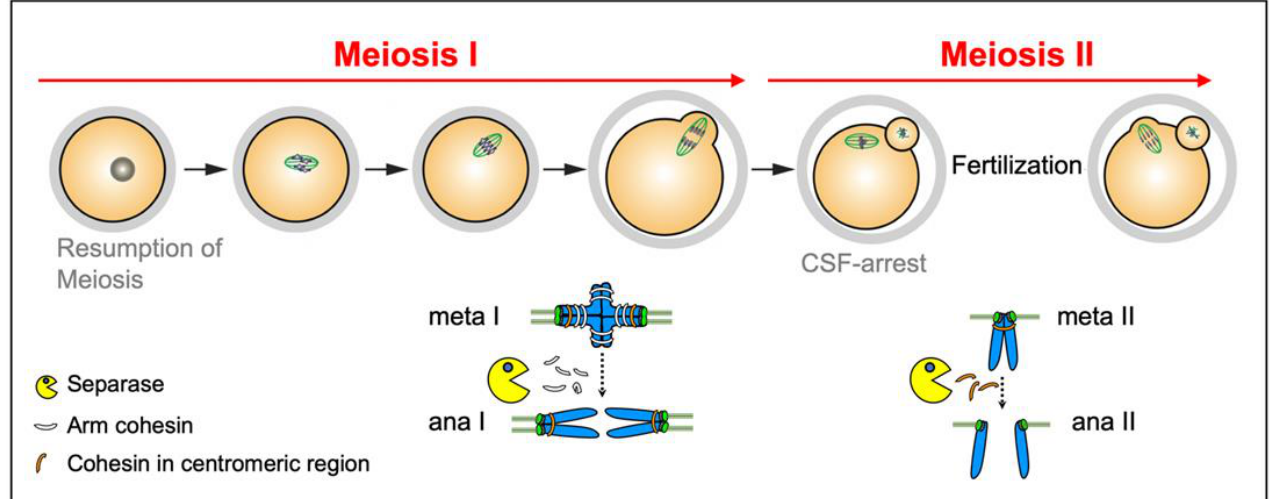
Figure 1. Mouse oocyte meiosis. Prophase I arrested oocytes are found in the ovaries of adult mice. Upon hormonal stimulation, they resume meiosis, with nuclear envelope breakdown and progression through meiosis I, followed by meiosis II. Oocytes arrest in the metaphase of meiosis II (CSF-arrest) to await fertilization, which induces anaphase II and exit from meiosis II. The meiotic divisions in oocytes are highly asymmetric to generate a small polar body that degenerates to maintain the volume of the oocyte for future embryo development. The segregation patterns are fundamentally different in meiosis I and II and are indicated in the scheme below, placed beyond the corresponding oocyte cell cycle stages. Separase (in yellow) removes arm cohesin (white) in meiosis I and centromeric cohesin (orange) in meiosis II. The typical cross-shaped form of paired chromosomes in meiosis I is due to chiasmata holding chromosomes of different parental origins together and the fact that mouse chromosomes are telocentric (centromeres are localized towards the ends of chromosomes).